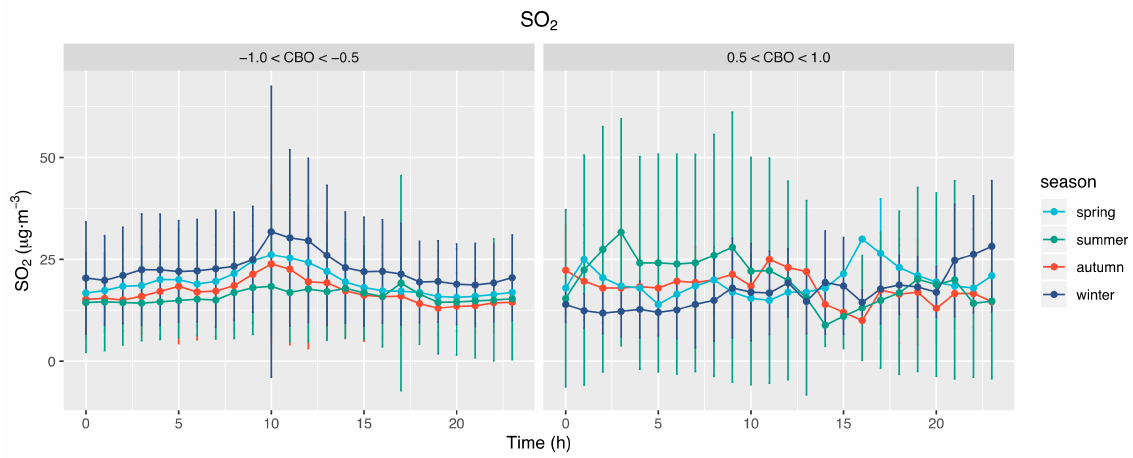
Figure 10. Diurnal variations of SO 2 in two situations: ( left ): − 1.0 < CBO < − 0.5 and ( right ): 0.5 < CBO < 1.0. As for CO (Figure 11), (1) while − 1.0 < CBO < − 0.5, the diurnal variations of CO concentrations showed a single peak pattern, peaking at around 10:00–11:00. Compared with the other seasons, CO in winter was the highest on average (1.12 µ g · m − 3 ). (2) While 0.5 < CBO < 1.0, CO concentration was also the highest on average in winter (1.14 µ g · m − 3 ), and CO in spring and summer was slightly lower than that for − 1.0 < CBO < − 0.5. As for the diurnal variations, while 0.5 < CBO < 1.0, CO did not show the single peak pattern as was shown while − 1.0 < CBO < − 0.5. CO was overall higher during 15:00–23:00 than 0:00–14:00.